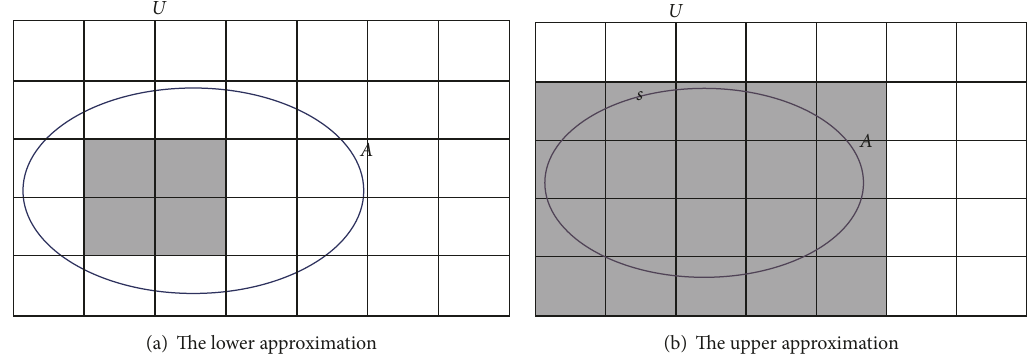
Figure 2: The concept 𝐴 is approximated by means of the lower and upper approximations [41,